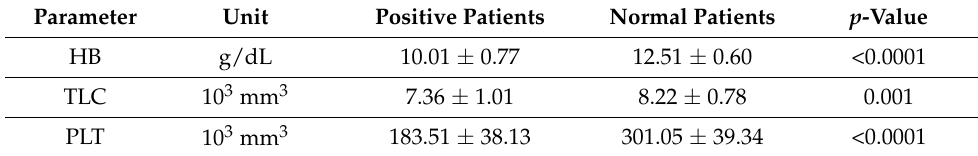
Table 5. Comparison of hematological parameters between HIV patients and healthy controls.